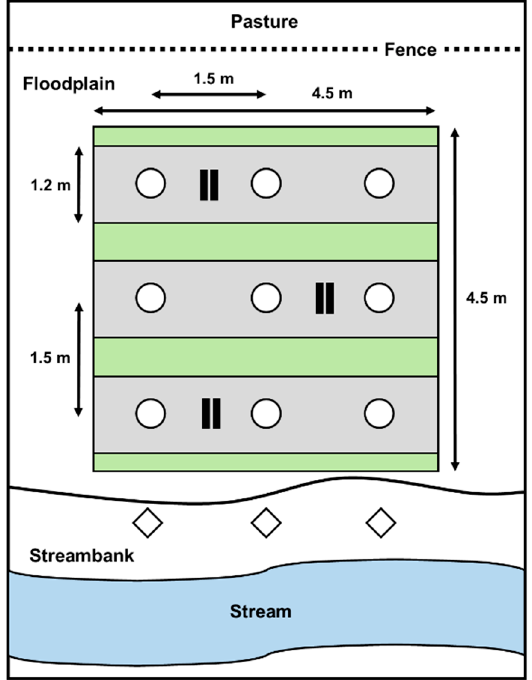
Figure 1. Schematic representation of an experimental plot for a single tree species (4.5 m × 4.5 m) that received a vegetation treatment (herbicide or plastic mulch). The plot is located in the floodplain zone and it contains nine trees (white circles) and a single vegetation treatment applied on each row on a 1.2 m wide strip (grey rectangles). Spacing between trees is 1.5 m × 1.5 m. Small black rectangles indicate the positioning of each pair of Plant Root Simulator (PRS)-probes ion exchange membranes. Hybrid willows (white diamonds) were planted between the top and toe of the streambank, outside the experimental plot.